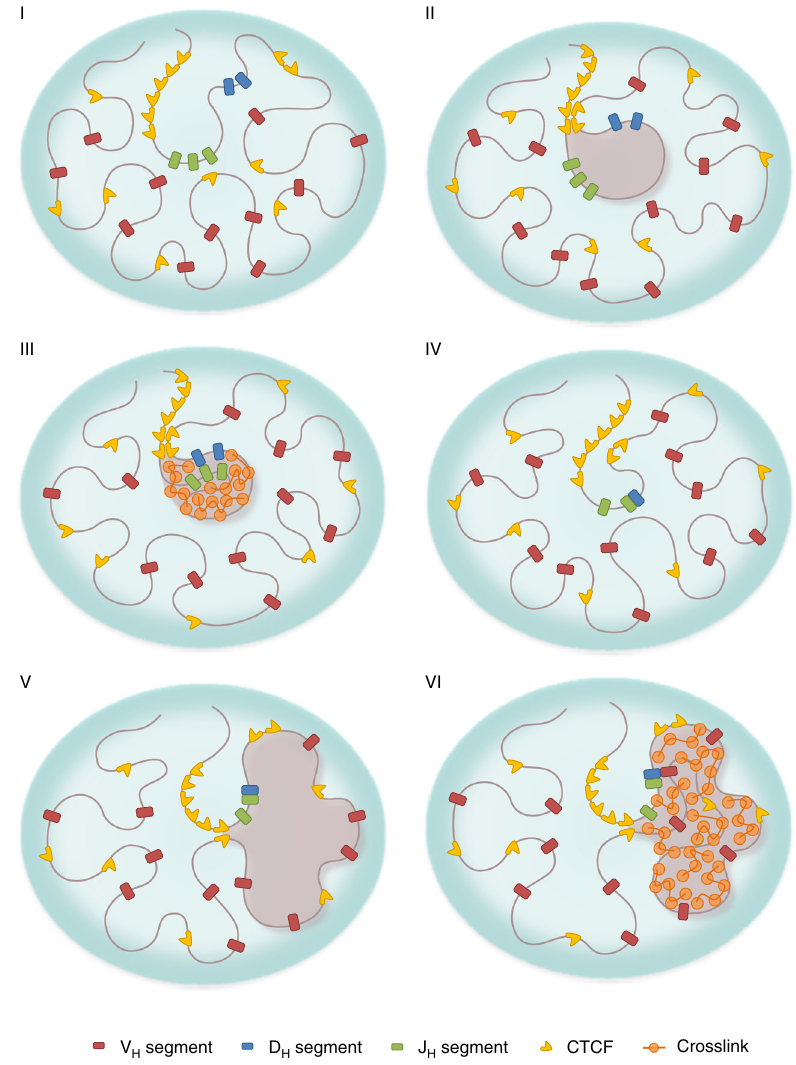
Fig. 6 The role of gelation in orchestrating ordered Igh locus rearrangement. (I) Igh locus harboring D H , J H , and V H regions in a germ-line con fi guration, in the absence of loop domains or crosslinks. (II) A chromatin loop domain containing D H and J H regions is formed, anchored by the CTCF sites fl anking the D H elements and the CTCF sites in the super-anchor. (III) Weak crosslinks are established across the loop domain containing D H and J H regions. The resulting gel droplet, which is phase-separated from the rest of the locus, facilitates encounters between D H and J H elements and hinders encounters with V H elements. (IV) The CTCF sites are inactivated and crosslinks are dissolved; the mobility of D H J H segment is increased. (V) Chromatin loops containing D H J H and V H regions are formed, anchored by the CTCF sites within the V H -cluster and the CTCF sites in the super-anchor. (VI) Crosslinks across a loop are established, resulting in a de novo gel droplet to facilitate V H -D H J H